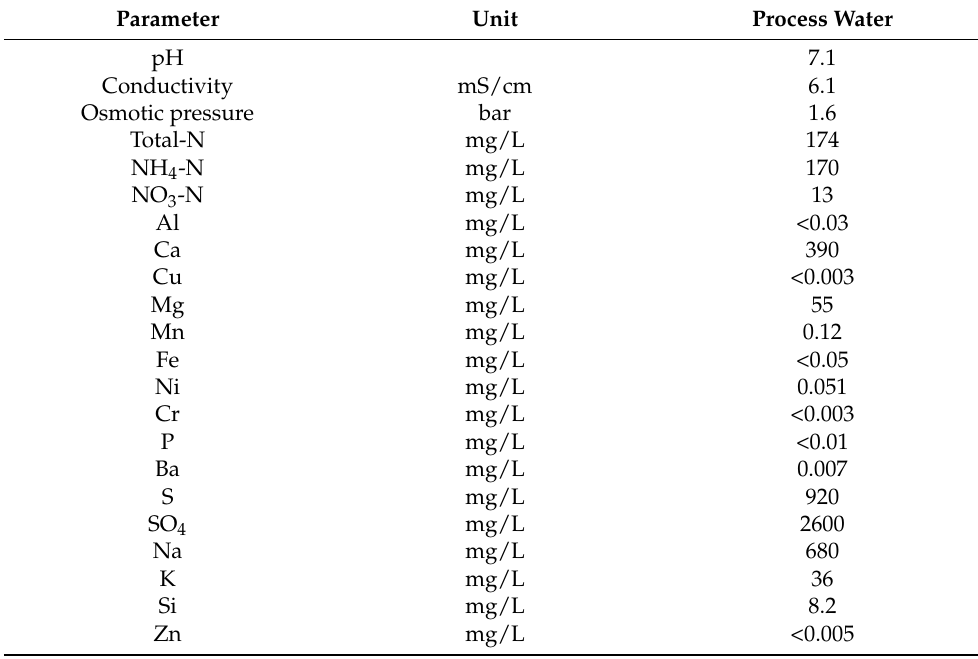
Table 1. Characteristics of mine water. Uncertainty of the measurements was 15–30%.